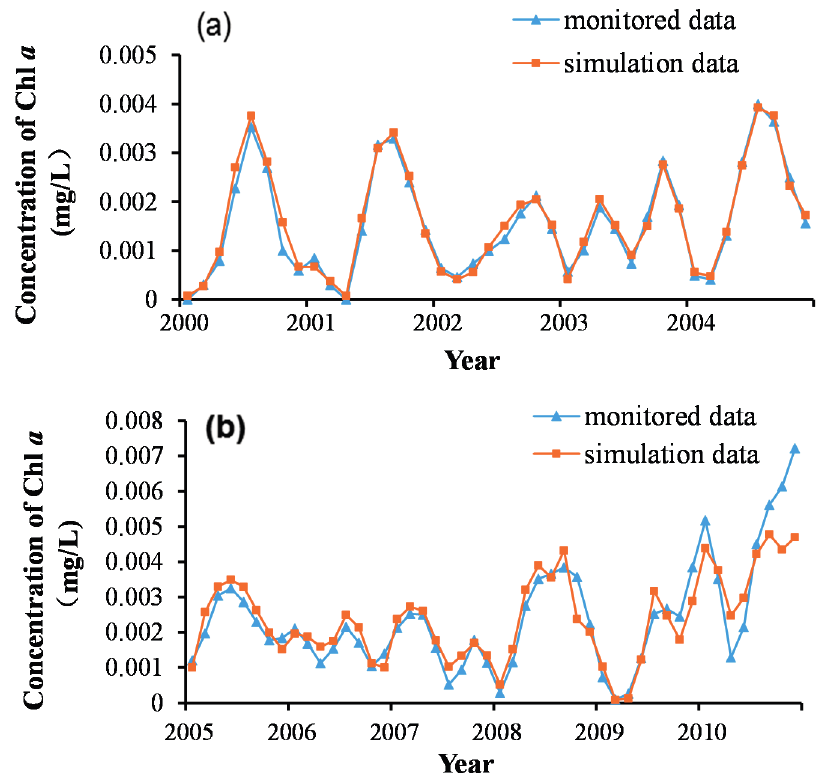
Figure 6. Training and prediction results of the SVM model: ( a ) training results and ( b ) prediction